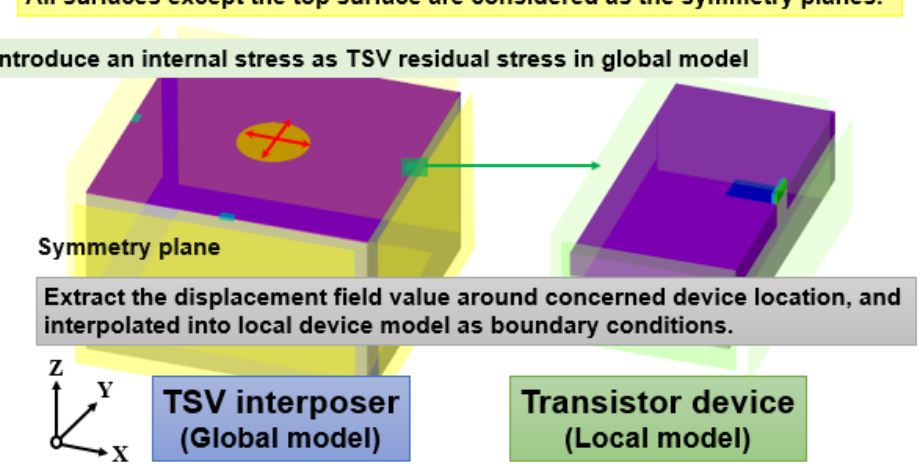
Figure 5. Schematic of how to introduce the TSV stress influence into the transistor device region based on the submodeling technique.